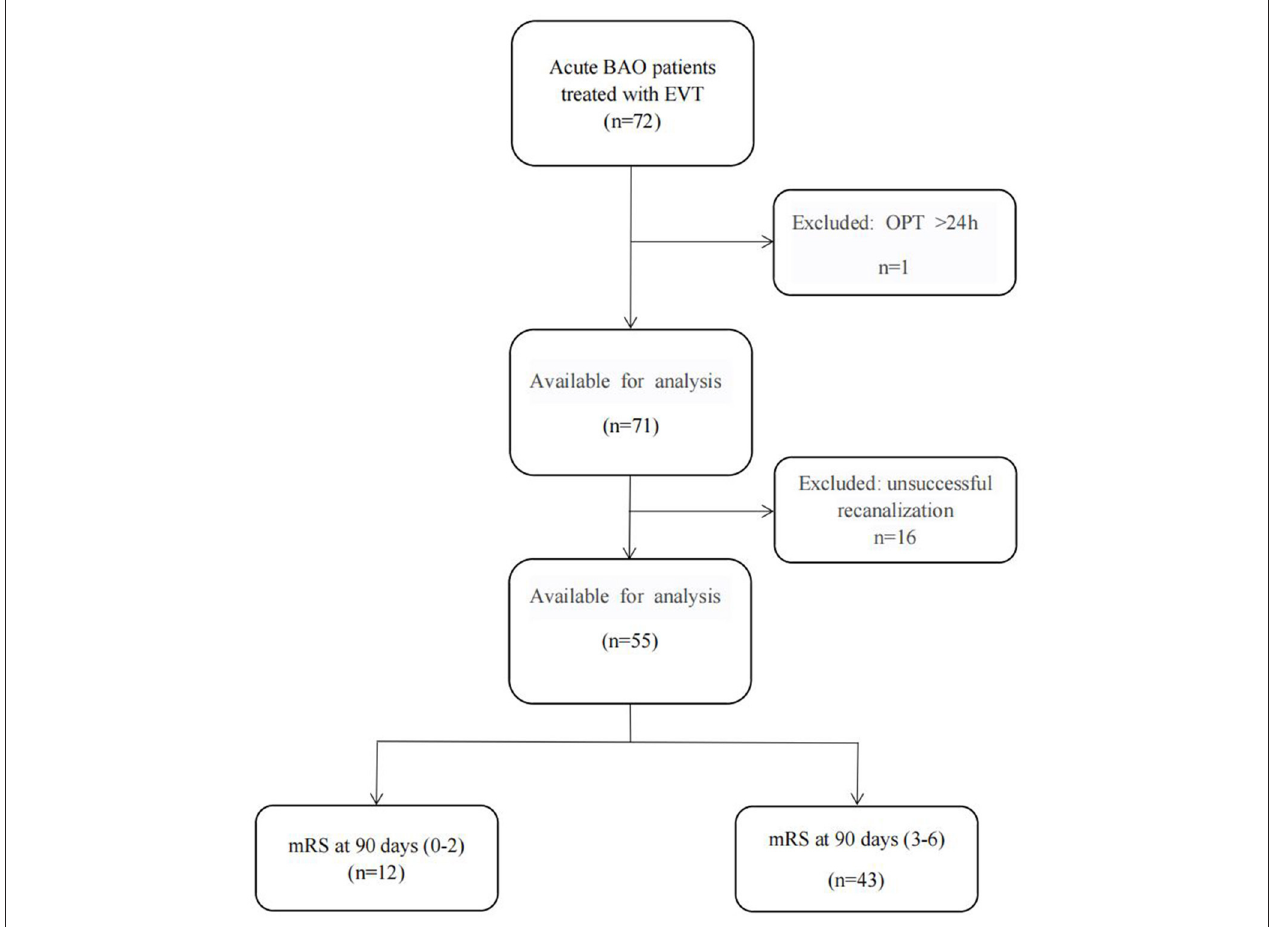
FIGURE 1 | The flow chart for the inclusion of patients. (BAO, basilar artery occlusive; EVT, endovascular thrombectomy; OPT, Onset-to-Puncture Time; mRS, the modified Rankin scale).